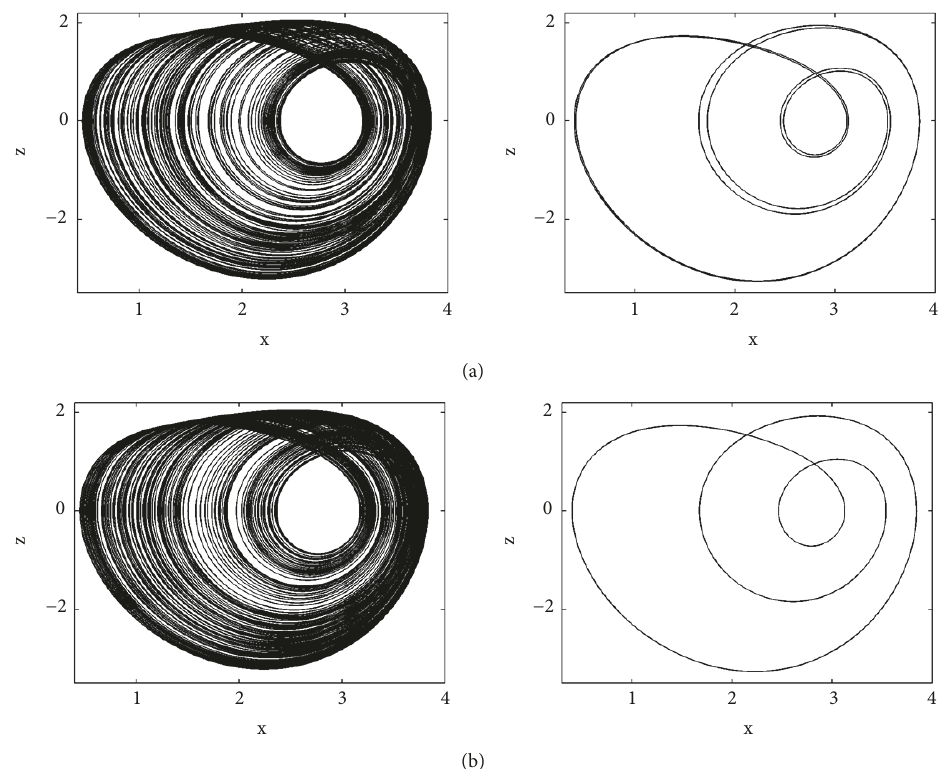
Figure 6: Phase portraits in the plane (𝑥,𝑧) for specific values of parameter 𝑏 : (a) 𝑏 = 3.185 and (b) 𝑏 = 3.189 . The initial conditions are (x(0), y(0), z(0)) = (1.0, 0, 0.5) in left column and (x(0), y(0), z(0)) = (3.0, 0, 0.5) in right column. The other parameter value is 𝑎 = 3.3